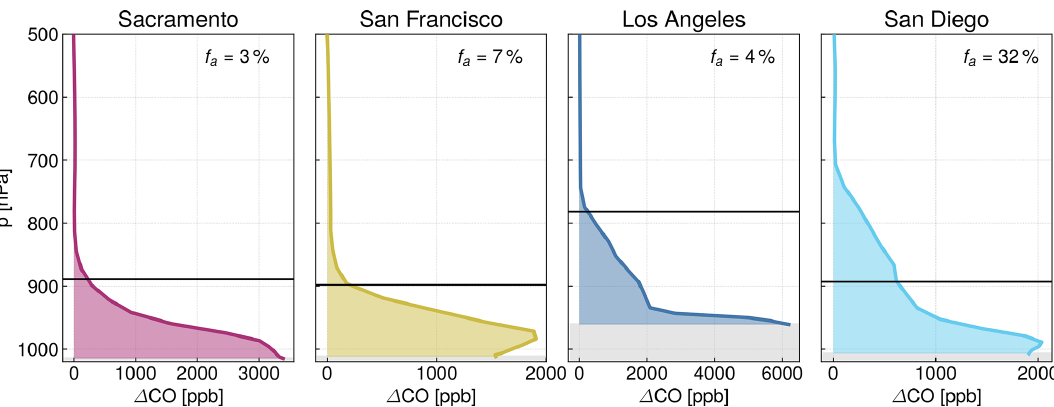
Figure 8. Mean CAMS CO profile enhancement relative to the prefire background (7 November). Fresno is not shown because there is no significant enhancement during 8–11 November in the CAMS model. The upper edges of the grey areas represent the surface pressure, the black vertical lines illustrate the upper bound of the uncertainty range of the estimated mean ERA5 boundary layer height, and f a is the CO mass fraction above the boundary